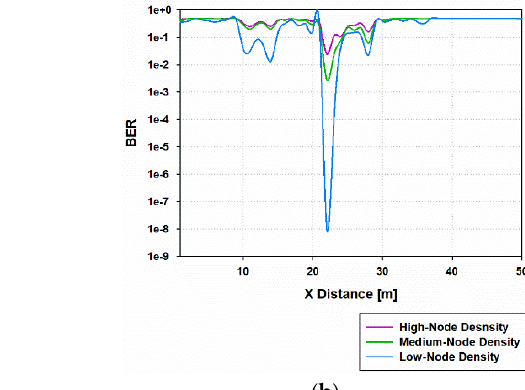
Figure 11. ( a ) Linear distribution line of EVM (%) for Y=20 m, X-axis in the considered scenario when indoor node is transmitting, ( b ) Linear distribution line of bit error rate for Y = 20 m, X-axis in the considered scenario when indoor node is transmitting.